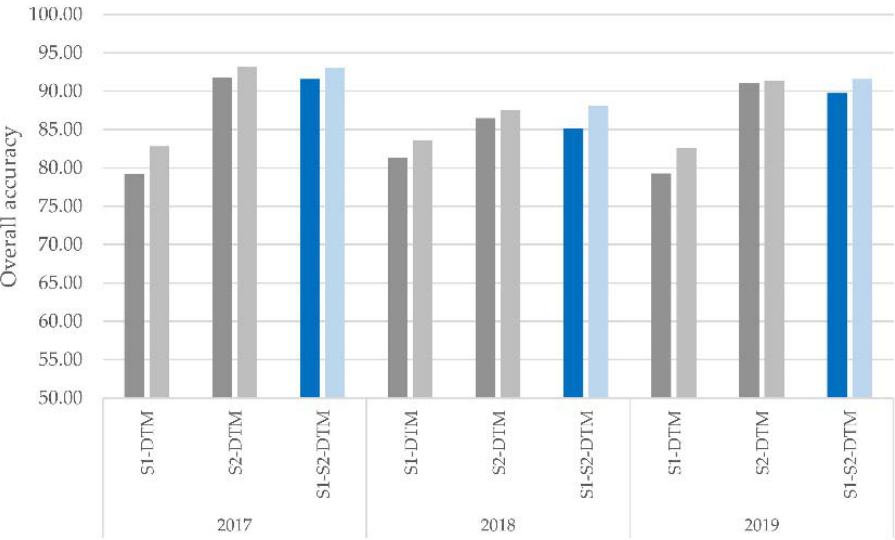
Figure 6. Comparison of the overall accuracy of grassland Random Forest classification for all years analysed, using a different combination of input data—separate optical (S2), radar (S1), and combined (S1–S2) SITS with environmental variables used for grassland intensity classification. Darker colours show the overall accuracy achieved from all available features. Lighter colours show the overall classification accuracy achieved by the model approach with feature selection based on MDA values.